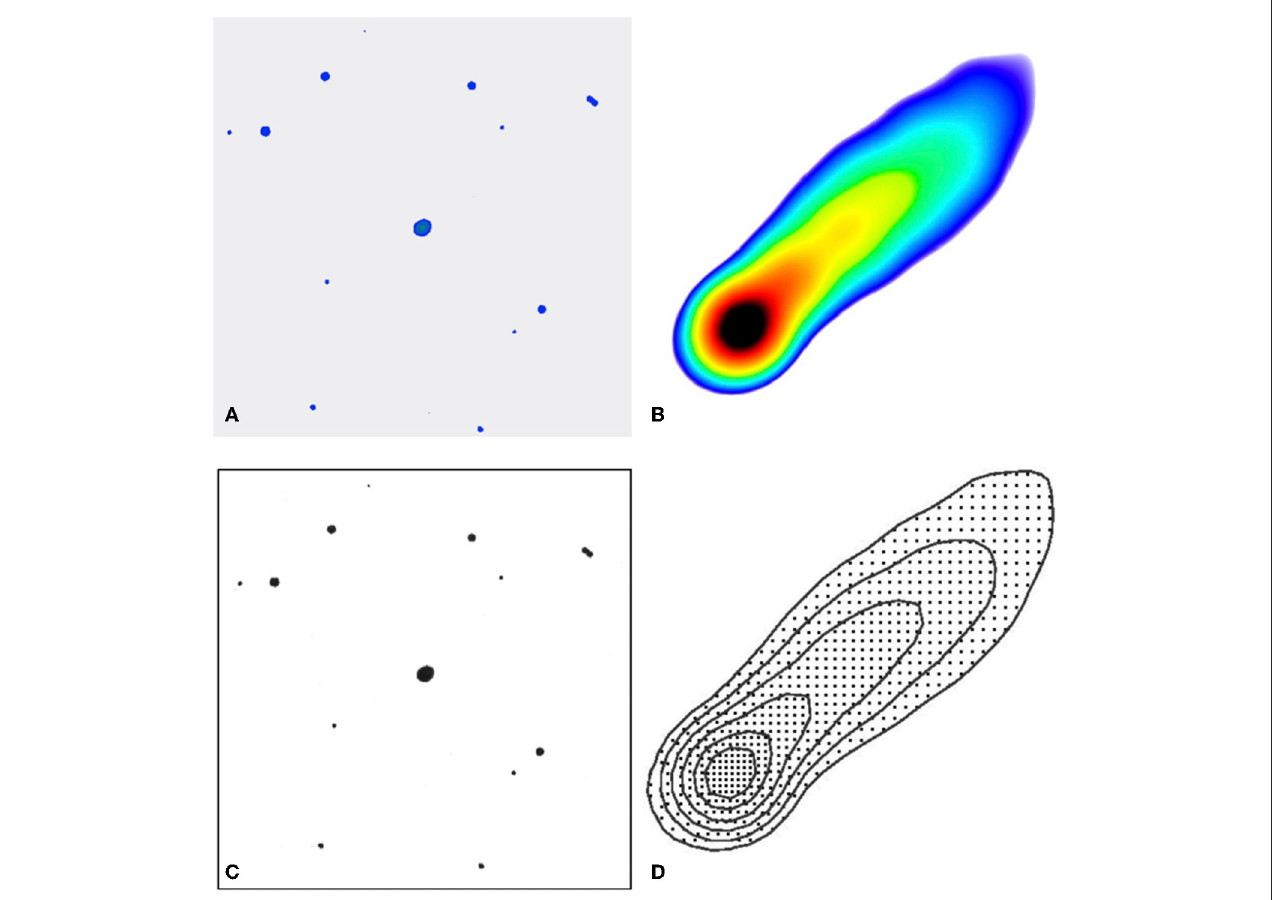
FIGURE1 Haptic representation of the radio sources. (A) False-color image of the radio waves emitted at 1.4 GHz (data NRAO/VLA Sky Survey, NVSS) by a 2 square degrees sky region centered on the source called 0206 + 35 (Right Ascension 02 h 09 m 38.9 s and Declination 35 ◦ 47 ′ 57 ′′ ). Blue color represents regions at intensity higher than 4 mJy/beam. (B) False color image of the radio emission of source 0206 + 35 at 1.4 GHz (data NVSS). Colors blue, green, yellow, orange, and red represent the ranges of intensity between the contour levels reported in (D) . Black color represents the region with intensity from ∼ 62 mJy/beam to the maximum value of ∼ 1.3 Jy/beam, with a beam of 1.7 arcseconds for VLA images at 1,4 GHz. (C) Visual rendering of the tactile map used to represent the sky region centered on the source 0206 + 35. (D) Intensity contours of the source 0206 + 35. at levels of 0.00827; 0.0136; 0.021; 0.032; 0.047; and 0.062 mJy/beam. The points inside each contour thin out from the center toward the outskirts, as the intensity of the radio waves